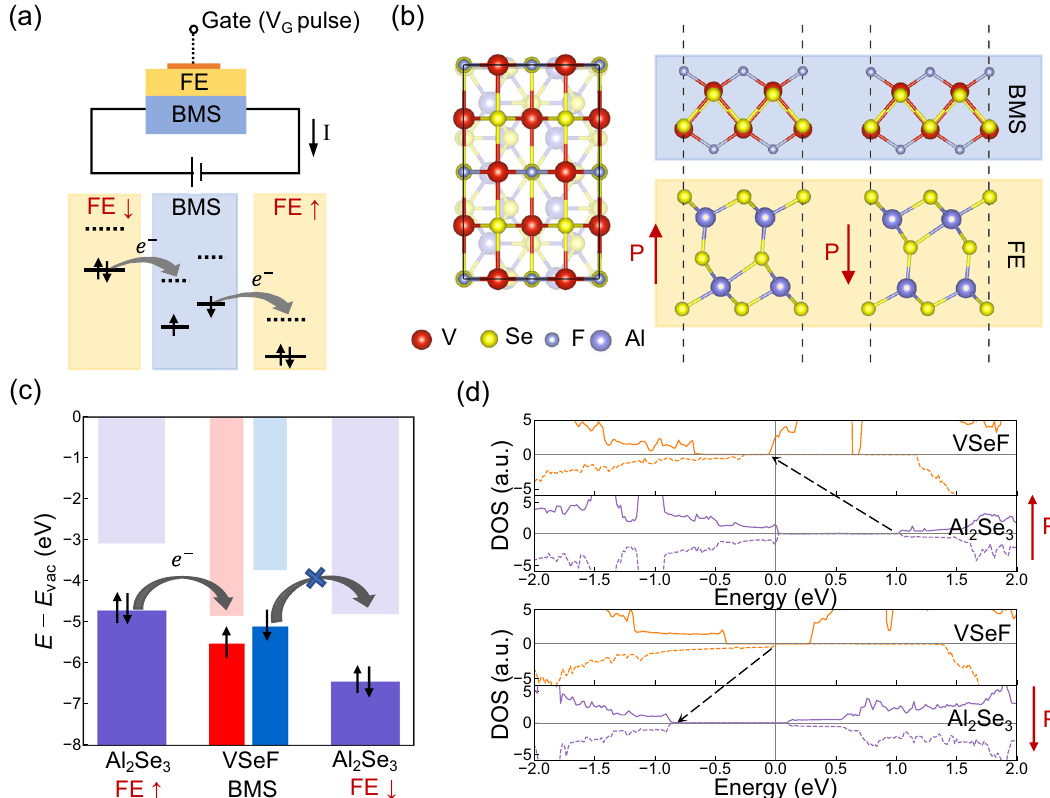
Fig. 3 Manipulation of BMS by the ferroelectric gate and VSeF/Al 2 Se 3 bilayer heterostructures. a Schematic diagram of spin FET based on BMS, the spin orientations in the conducting channel (BMS region, marked in blue) can be controlled by switching the electric polarization of ferroelectric dielectric (FE region, marked in yellow). The bottom panel depicts the desired band alignments between BMS and FE under different ferroelectric polarized states, and associated charge transfers. Here, the solid and dashed lines represent VBM and CBM, respectively. Black arrows denote the electron spin, where electrons fi ll to the VBMs. The spin-up and spin-down bands of BMS are split, due to the intrinsic magnetism of BMS. b Top and side views of VSeF/Al 2 Se 3 bilayer heterostructures. The red arrow represents the polarization direction of Al 2 Se 3 . c Band alignments of VSeF/Al 2 Se 3 ( ↑ ) and VSeF/Al 2 Se 3 ( ↓ ) with respect to the vacuum level of VSeF. The red and blue bars show the band edges of spin-up and spin-down channels of BMS, respectively, the purple bars show the band edges of FE. d Layer-resolved PDOS of VSeF/ Al 2 Se 3 ( ↑ ) and VSeF/Al 2 Se 3 ( ↓ ), where the orange and purple lines represent the PDOS contributed by VSeF and Al 2 Se 3 , respectively. The potential energy decreases along the direction of black dashed